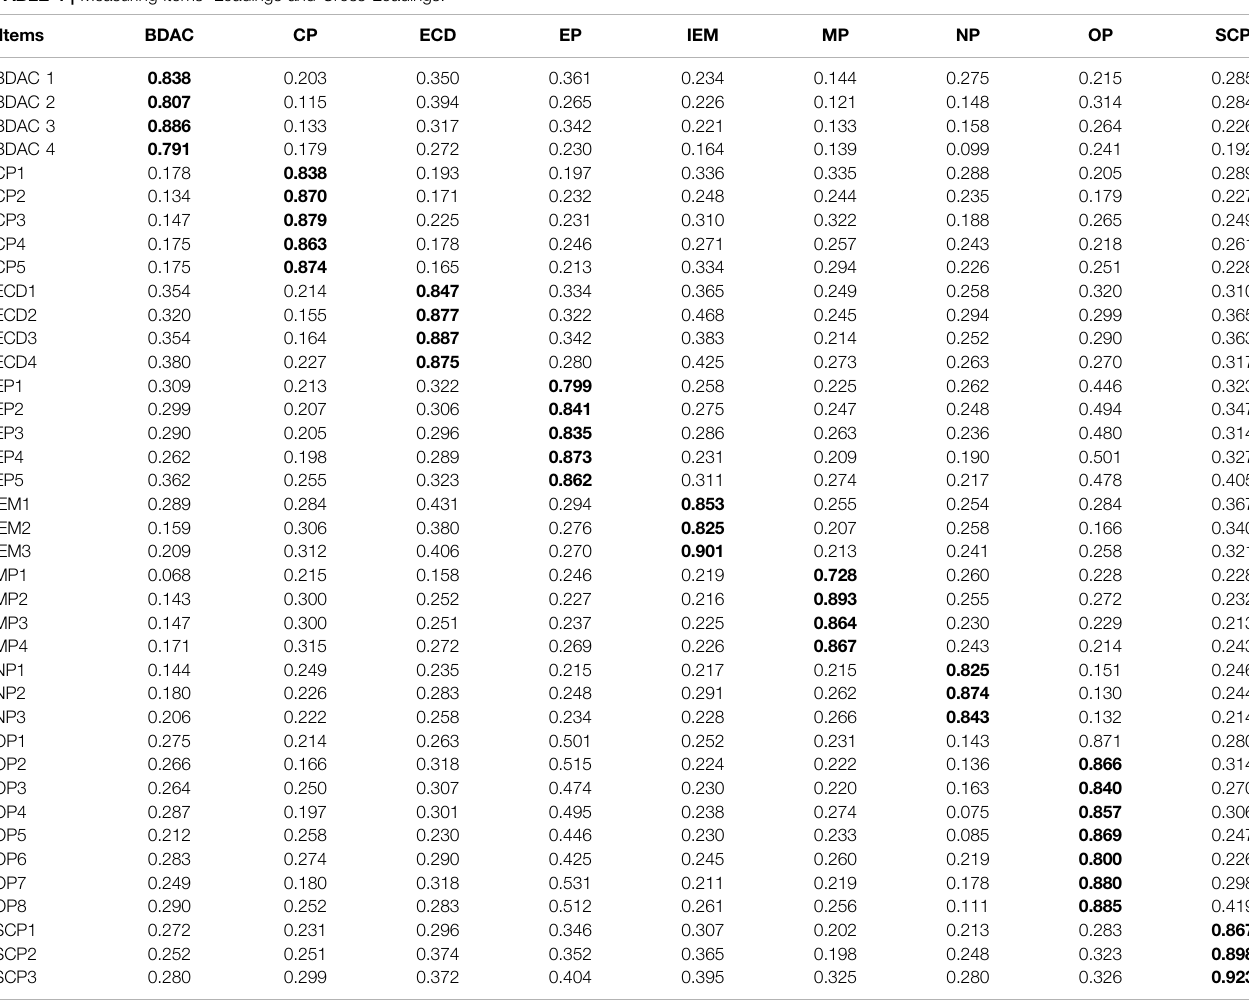
The bold-faced values are the item